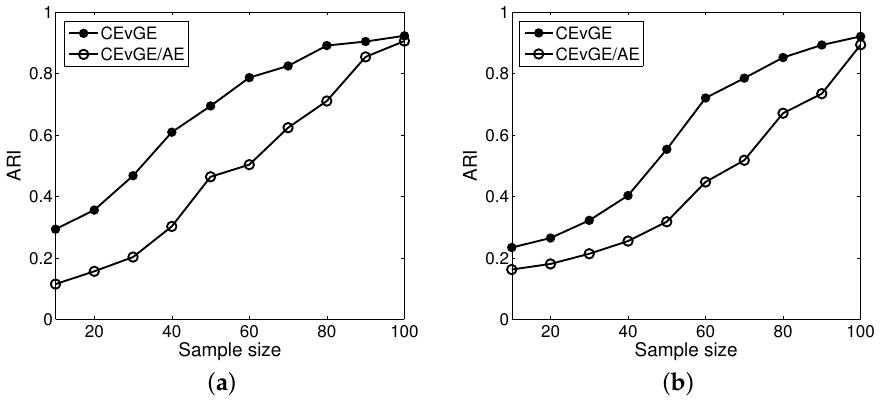
Figure 3. Test of generative ability on randomly sampled data sets. ( a ) ARI metrics on KDD’99. ( b ) ARI metrics on MNIST.